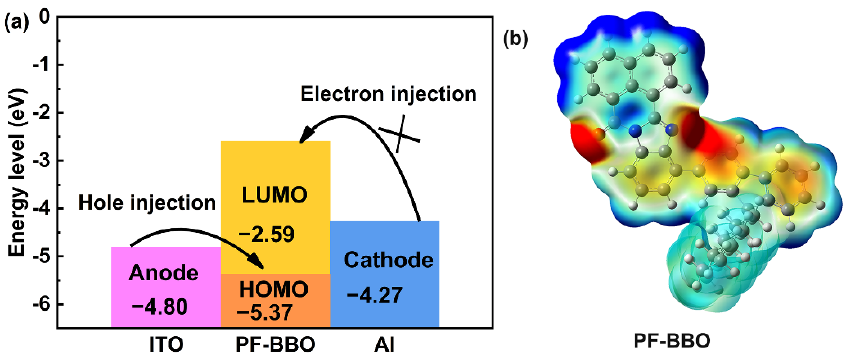
Figure 10. ( a )Transition diagram showing the energy level of ITO/PF-BBO/Al device; ( b ) ESP molecular orbital electron cloud distribution of PF-BBO.